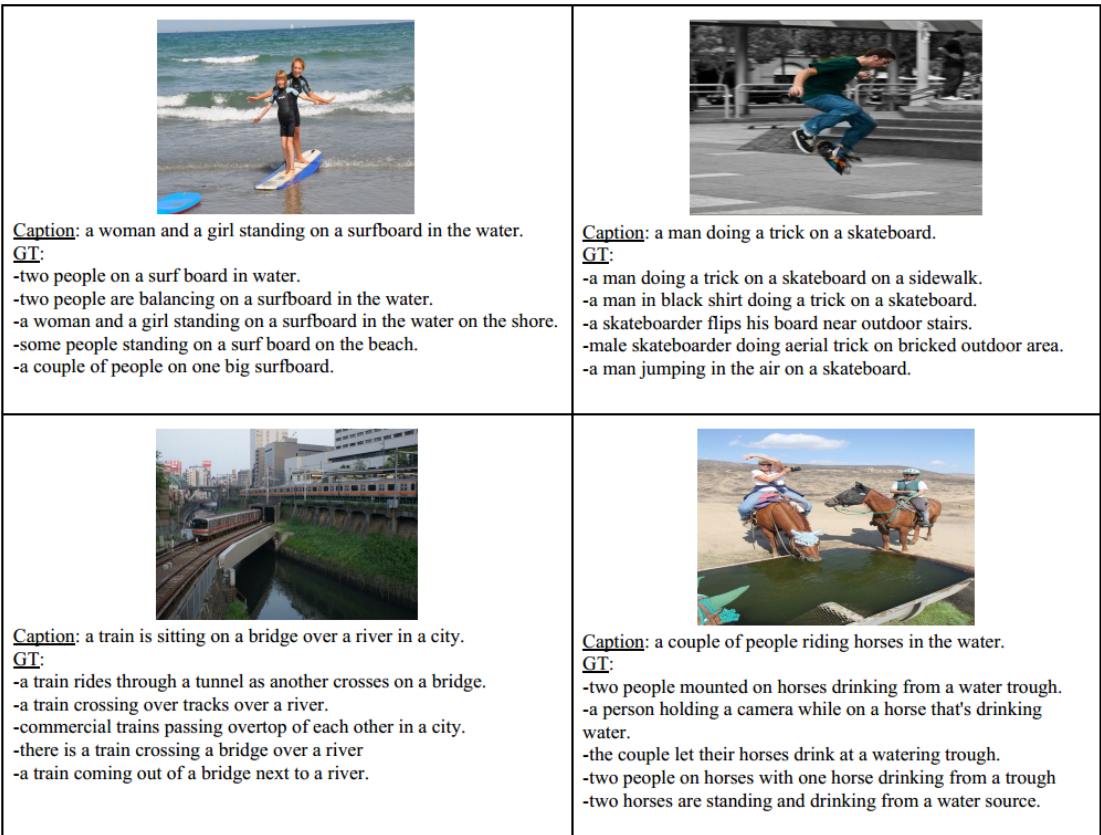
Figure 5. The qualitative comparison between the captions generated by our model and the ground truth (GT) captions randomly picked from the MSCOCO